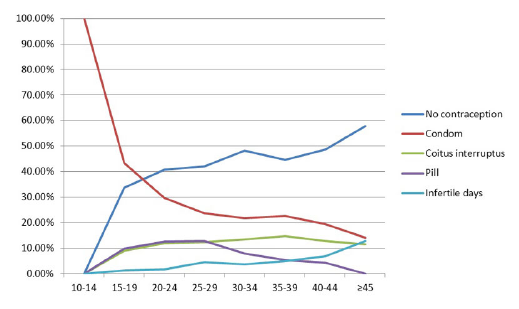
Figure 3: Percentage distribution of pre-VTP contraception method according to the woman’s age by woman’s age at termina- tion according to nationality and residence groups. VTP = volun- tary termination of pregnancy